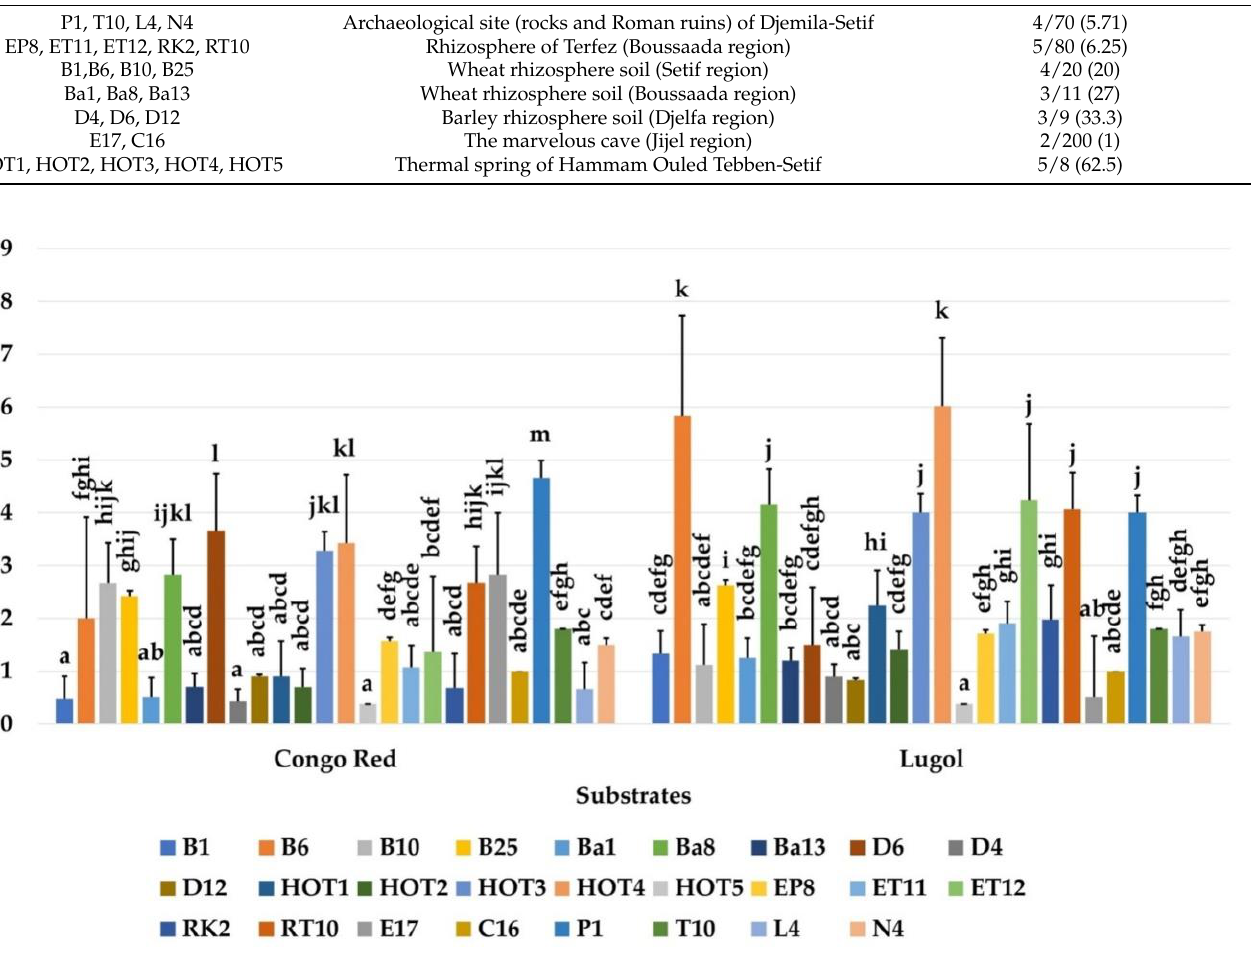
Table 1. Selected bacterial isolates ( n = 26) with cellulase activity from various environments.